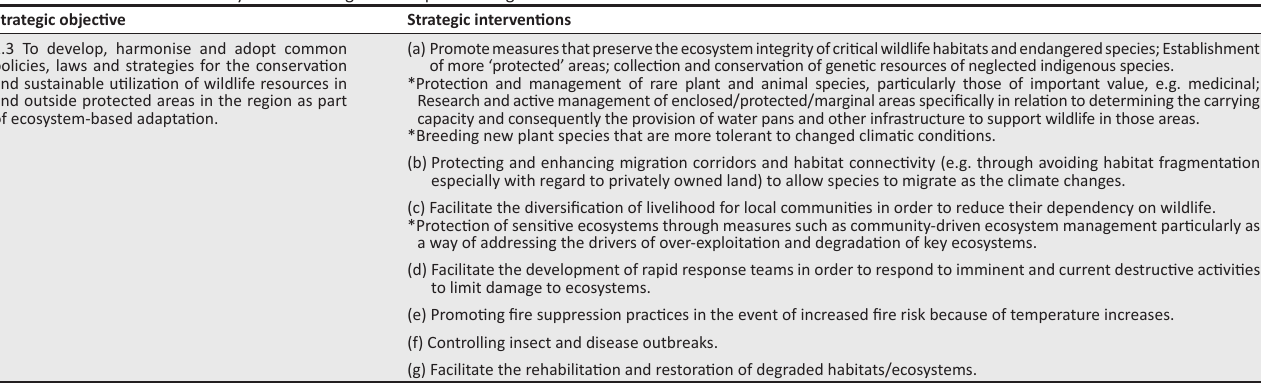
TABLE 4: East African Community climate change master plan strategic interventions for the wildlife sector. Strategic objective Strategic interventions